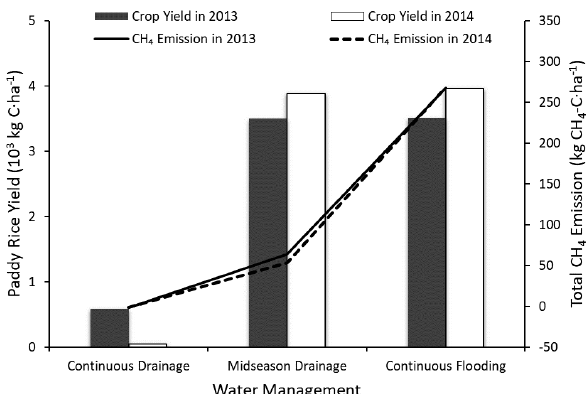
Figure 10. Changes in crop yield and CH 4 emission with different field irrigation management.